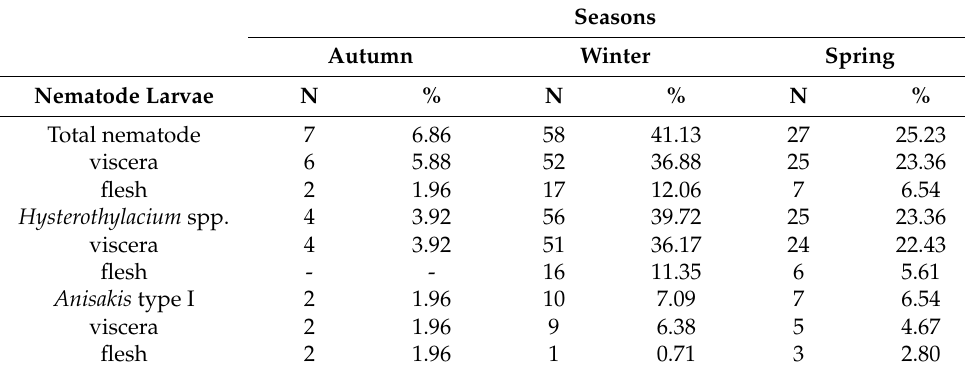
Table 4. Number (N) and prevalence (%) of sardines parasitized by nematode larvae according to the season of catch.